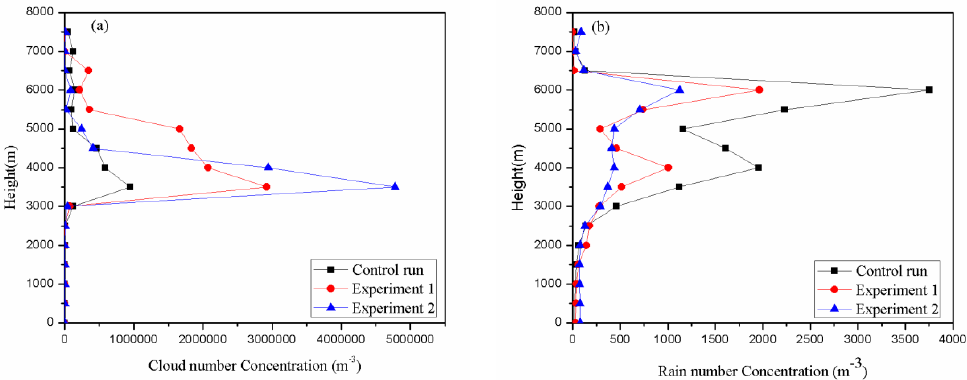
run, respectively. run, respectively. Figure 6. Median diameter comparisons on 16 August 2008 for WDM6 at near-surface level.